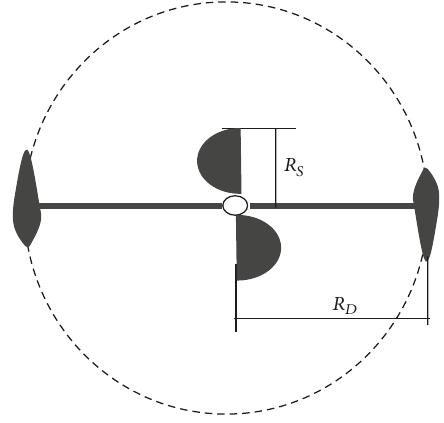
Figure 2: Combined Darrieus and Savonius turbine.